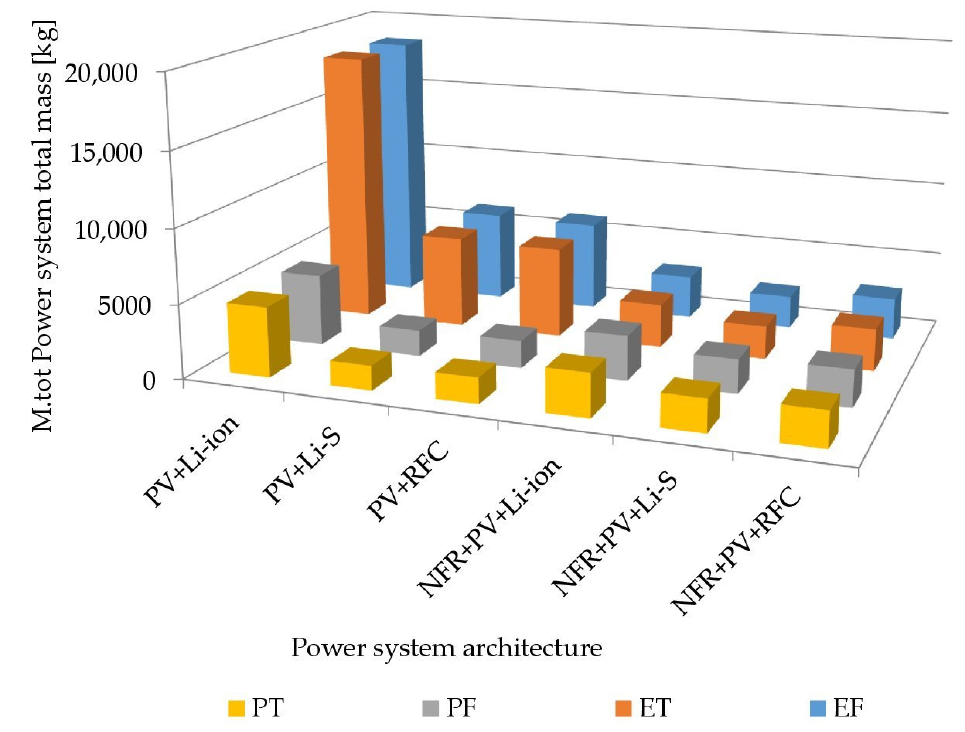
Figure 6. Total mass of the power systems with different solar array structures for specified site illumination.